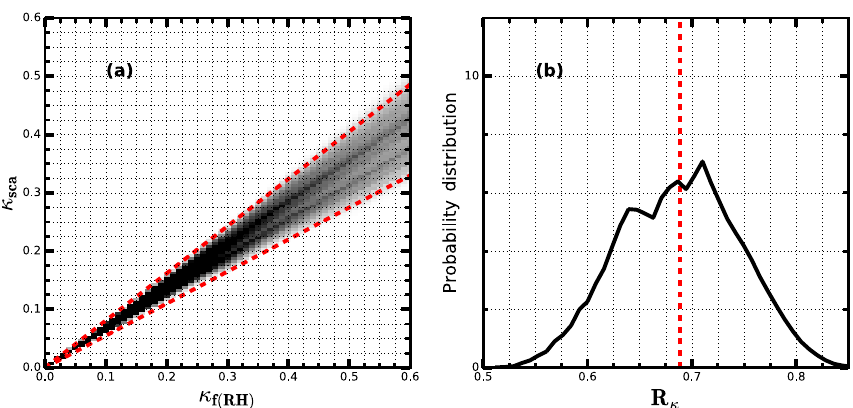
Figure 5. (a) Simulated relationships between κ f( RH ) and κ sca under different PNSD conditions (all PNSDs shown in Fig. 3a are used as inputs to conduct the simulation experiment). The gray color represents the frequency and darker points correspond to a higher frequency. The slopes of the two dashed lines are 0.55 and 0.81. (b) The probability distribution of R κ ( κ sca /κ f( RH ) )